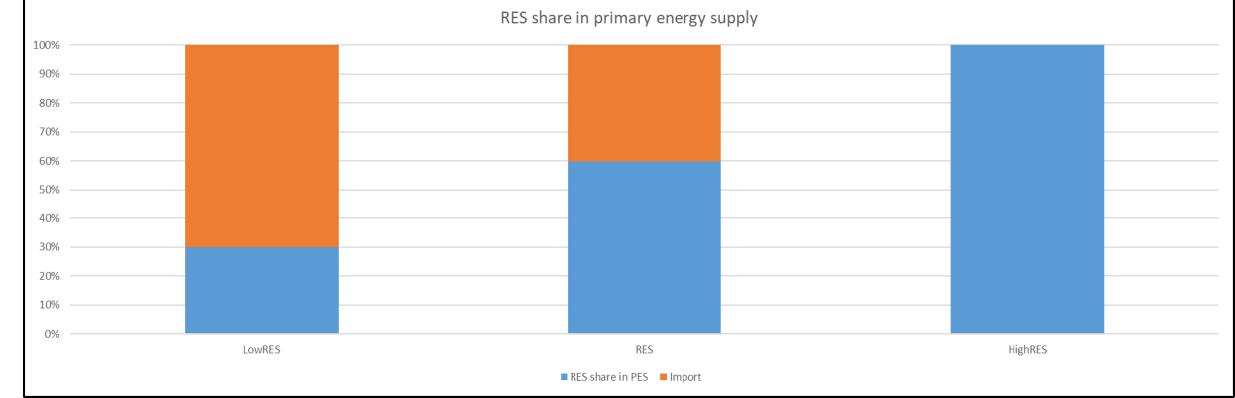
Figure 5. RES share in primary energy supply. Table 4. Results of modelling — energy generation from